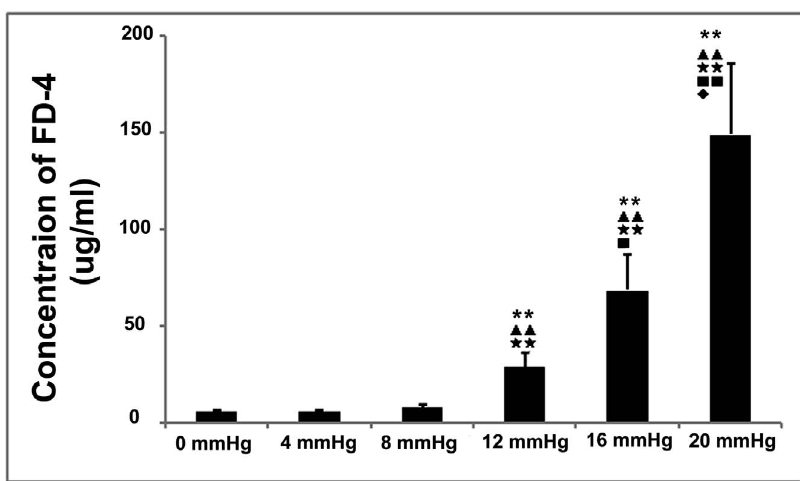
Figure 3. The effects of different grades of nitrogen pneumoperitoneum on intestinal permeability to FD-4. Intra-abdominal hypertension significantly stimulated the intestinal permeability to FD-4.Compared with that in the 0-mmHg group, the FD-4 concentration in the 12-, 16-, and 20-mmHg groups were increased 5.2-,12.4- and 26.7-fold, respectively. Slightly elevated intra-abdominal pressures of 4 and 8 mmHg did not affect the FD-4 concentrations. No significant differences were observed between the 0-mmHg group and the 4- and 8-mmHg groups. All data are shown as means 6 SD. **P , 0.01, vs. 0 mmHg; mm P , 0.01, vs. 4 mmHg; ww P , 0.01, vs. 8 mmHg; & P , 0.05, vs. 12 mmHg; X P , 0.05, vs. 16 mmHg.